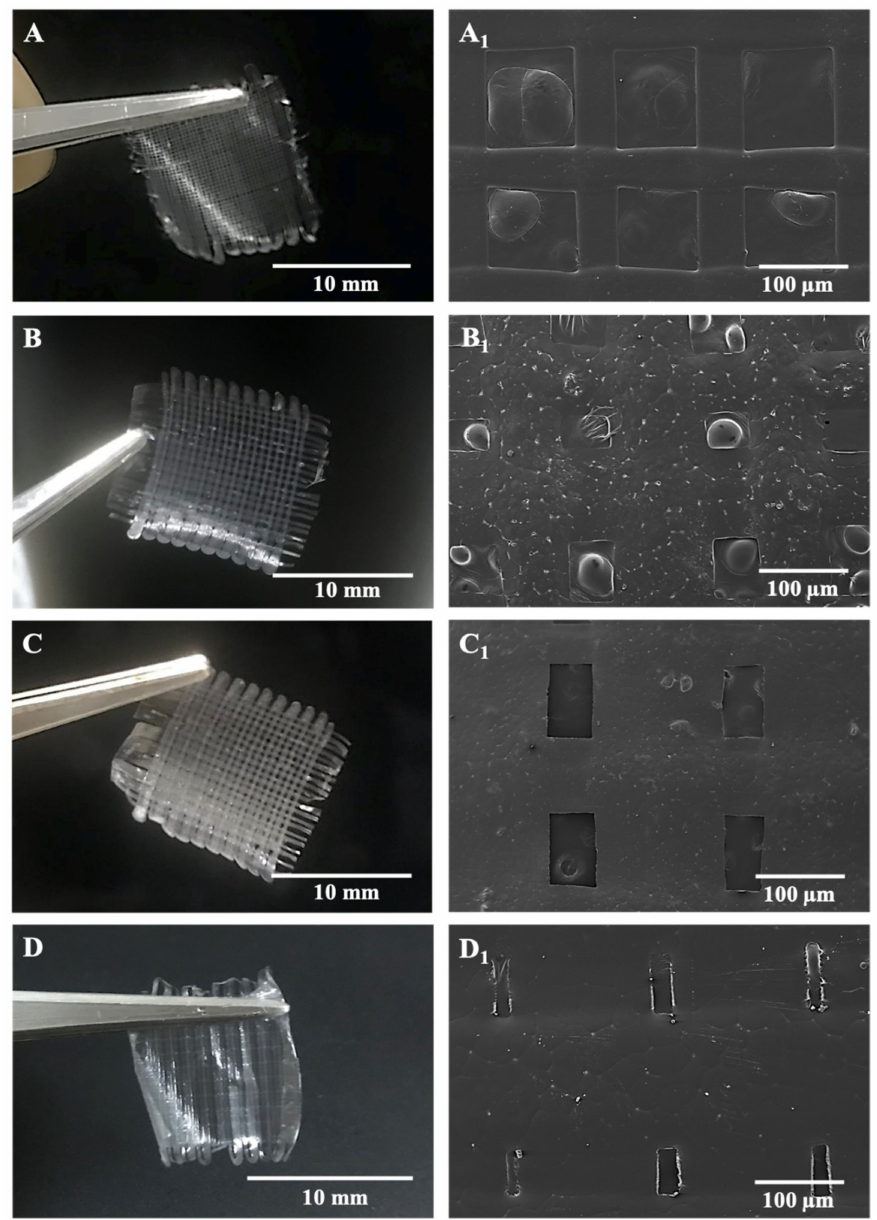
Figure 3. SEM images of EHD-3D printed patches with digital photographs of BC/PCL 5:95 (wt. ratio) patch with inter-fibrous pore size 100 × 100 µ m 2 ( A , A 1 ), AMX-loaded patch with inter-fibrous pore size 100 × 100 µ m 2 ( B , B 1 ), AMP-loaded patch with inter-fibrous pore size sub-100 × 100 µ m 2 ( C , C 1 ) and KAN-loaded patch with inter-fibrous pore size sub-100 × 100 µ m 2 ( D , D 1